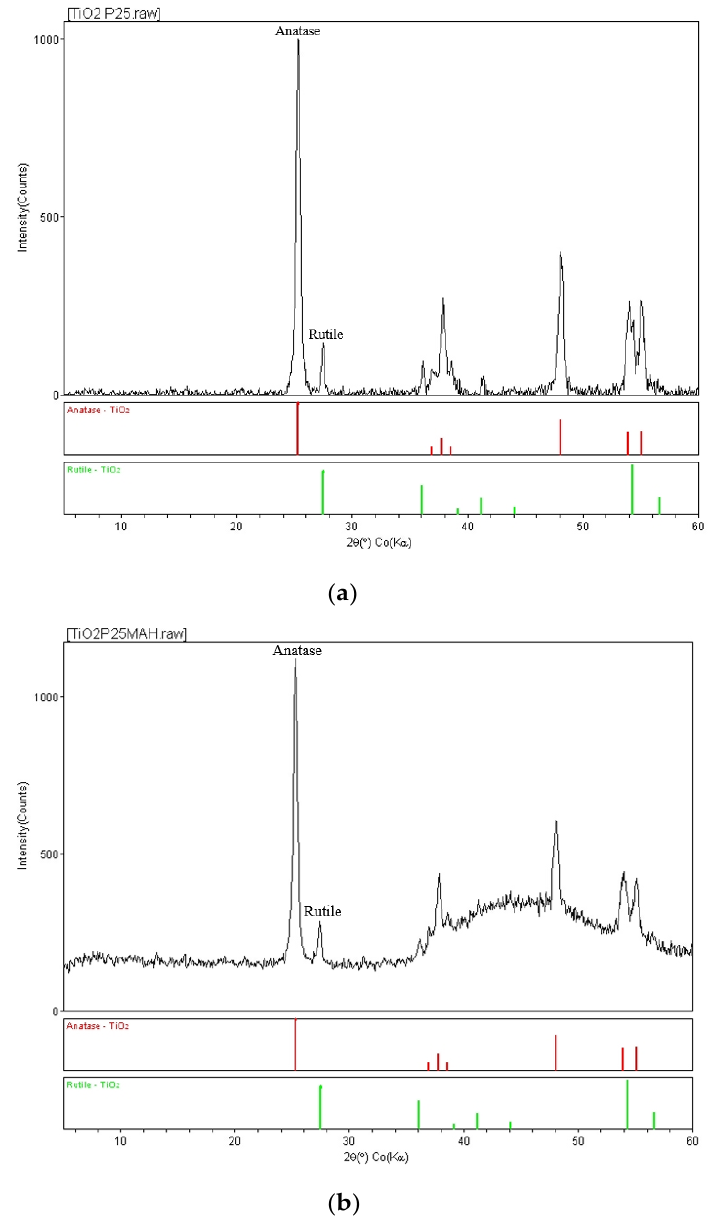
Figure 3. ( a ) XRD diffractogram of P25 titanium dioxide. ( b ) XRD diffractogram of functionalized Ti-MAH powder.